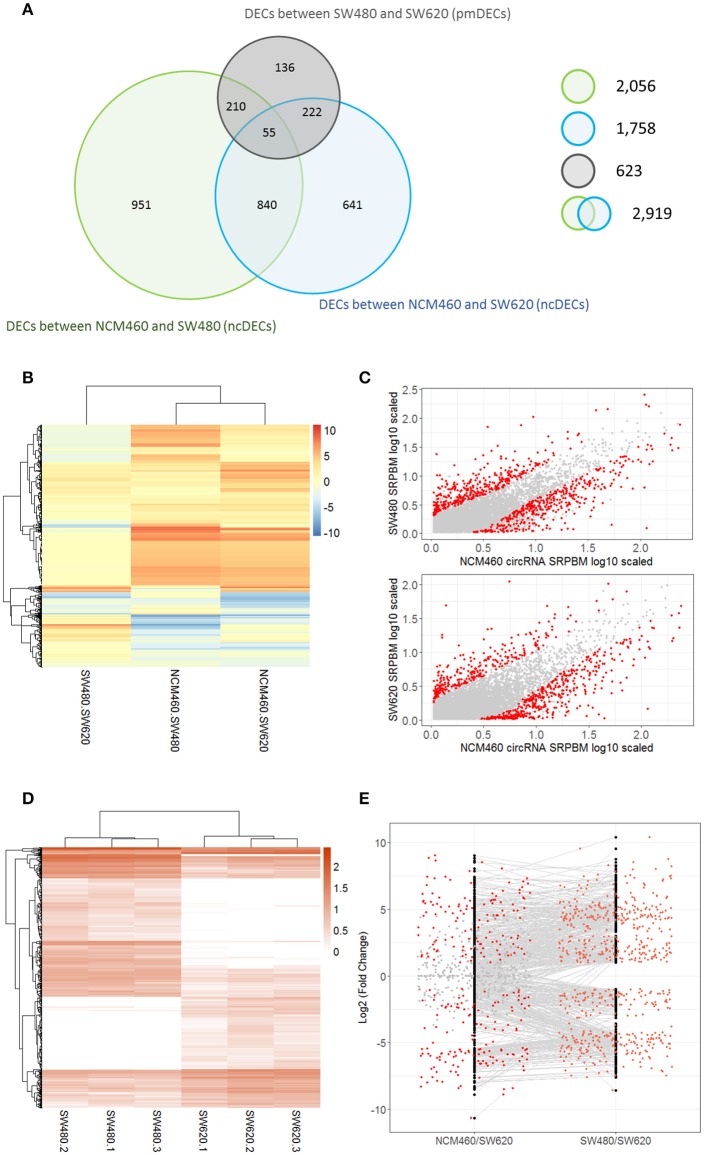
Number and expression patterns of differential expressed circRNAs (DECs) between the CRC lines (SW460 and SW480) and NCM460. (A) Number of DECs in different groups. Green, blue, gray circles represent the quantity of DECs between NCM460 and SW480, NCM460 and SW620, SW480 and SW620, respectively. (B) Clustered heatmap of 2,919 ncDECs, with columns representing different circRNAs, and rows representing fold-changes between the corresponding two cell lines. (C) Normalized expression values (SRPBM) of circRNAs in NCM460 vs. SW480, NCM460 vs. SW620, respectively. Red and gray points represent significantly differential expressed and non-significantly differential expressed circRNAs, respectively. (D) Clustered heatmap of 623 pmDECs, with columns representing different circRNAs, and rows representing three biological replicates of SW480 and SW620. (E) Expression fold-changes on log-scale of 623 pmDECs in SW480 vs. SW620 (right) and NCM460 vs. SW620 (left). Orange points represent DECs in SW480 vs. SW620. Red and gray points represent DECs and non-DECs in NCM460 vs. SW620.